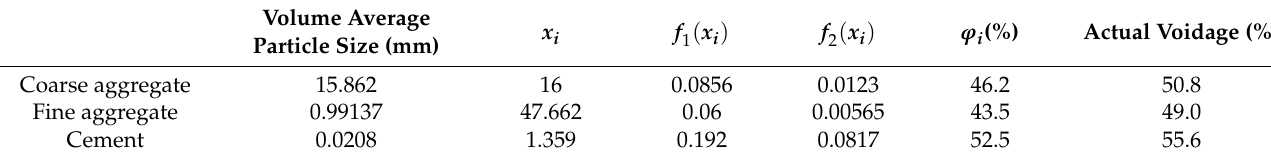
Table 6. Actual voidages of granular materials in